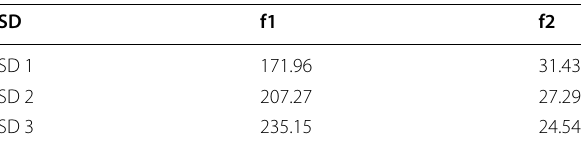
Table 8 Difference factor (f1) and similarity factor (f2) values